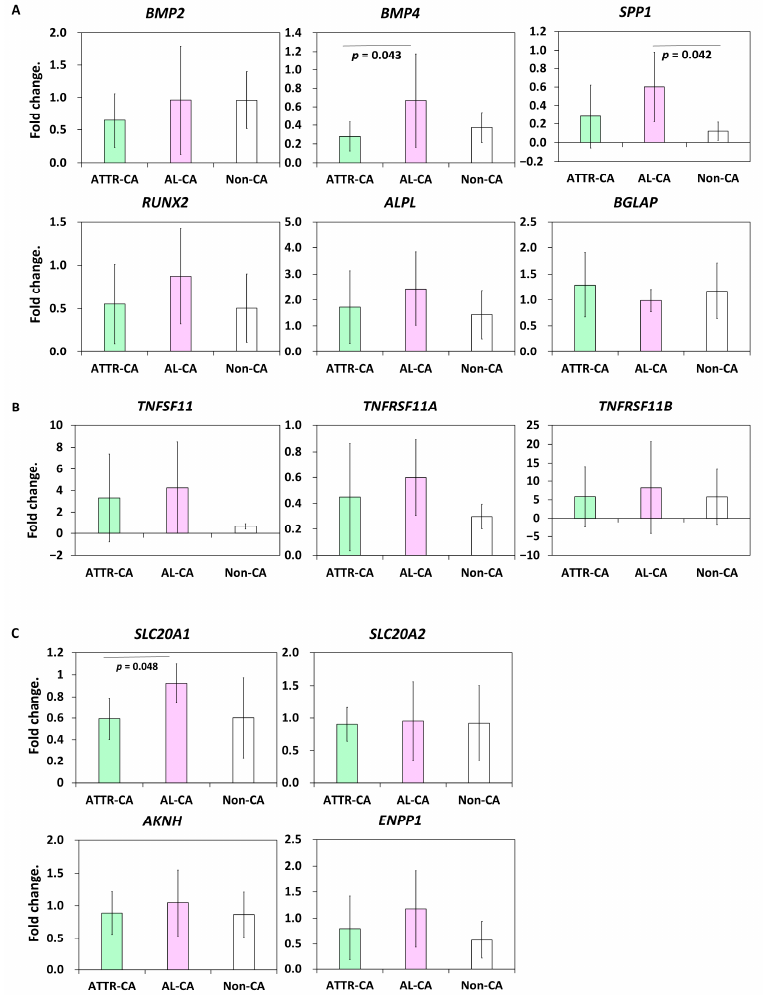
Figure 4. Comparison of bone metabolism-related gene expressions in endomyocardial biopsy sam- ples. ( A ) Expression levels of osteogenic markers. ( B ) Expression levels of osteoclastic gene markers. ( C ) Expression levels of phosphate and pyrophosphate-related genes. N = 11 in the transthyretin cardiac amyloidosis (ATTR-CA) group, N = 6 in the amyloid light-chain cardiac amyloidosis (AL- CA) group, and N = 6 in the noncardiac amyloidosis (non-CA) group. ANOVA/Bonferroni test was